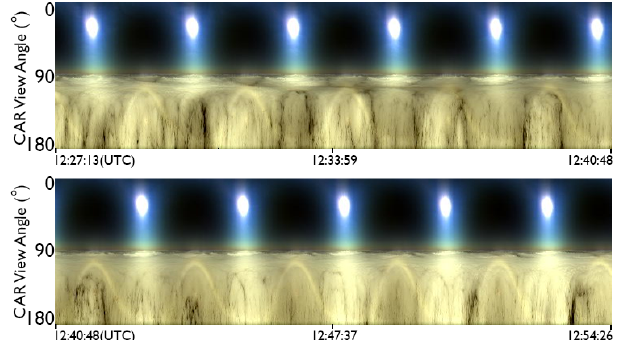
Figure 3. CAR quick-look image (constructed from three bands at 1.04, 0.87, and 0.47µm) obtained over marine stratocumulus clouds. The circular flight track by the aircraft allows the CAR to image the sky and surface in all viewing zenith and azimuthal an- gles, covering an area defined by a diameter of about 4km on the surface (assuming the aircraft is flying 600m above the surface). The unique feature of these measurements is the solar disks, which define the start and end point for each circle. A prominent feature of the marine stratocumulus clouds is the presence of a cloud bow ring associated with scattering by water droplets and with a peak at an approximately 75 ◦ zenith angle in the antisolar